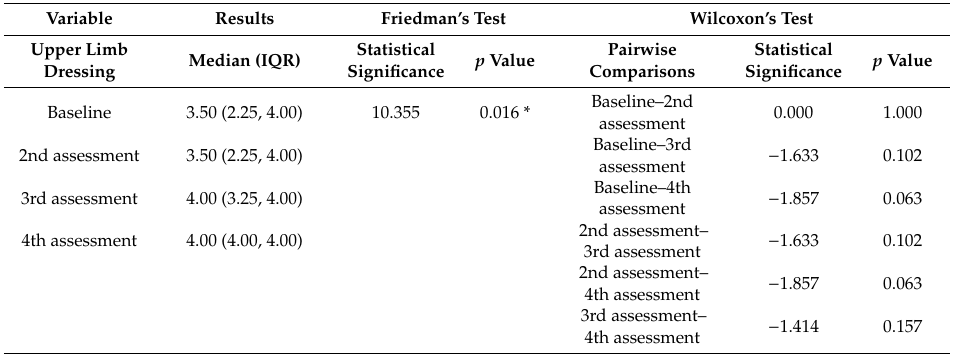
Table 8. Results and pairwise comparisons of upper limb participation in activities of daily living (SHUEE).